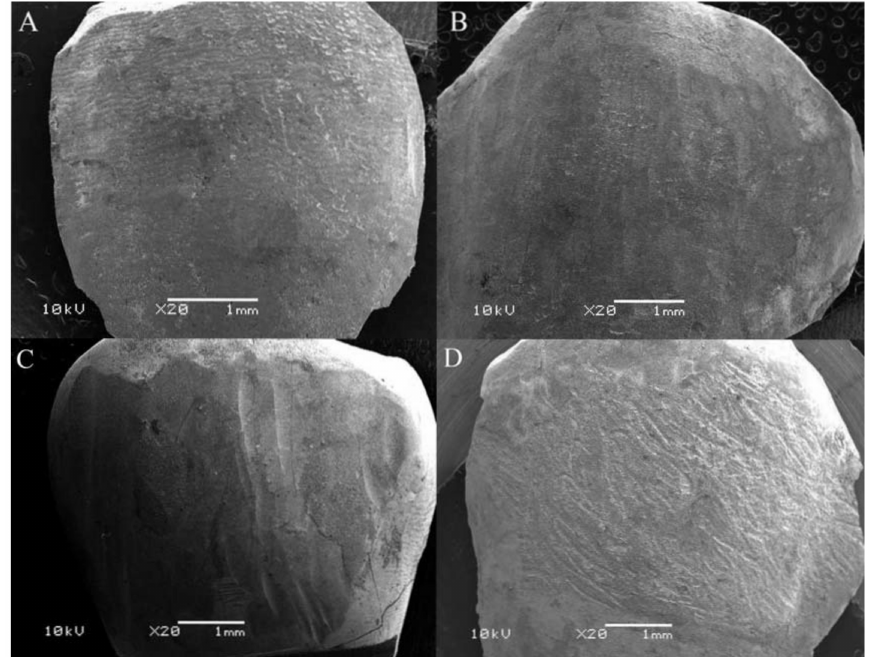
Figure 1. SEM images. ( A ) Healthy Group. ( B ) Group 1 classified as satisfactory score. ( C ) Group 2 showing imperfect surface. ( D ) Group 3 with unacceptable